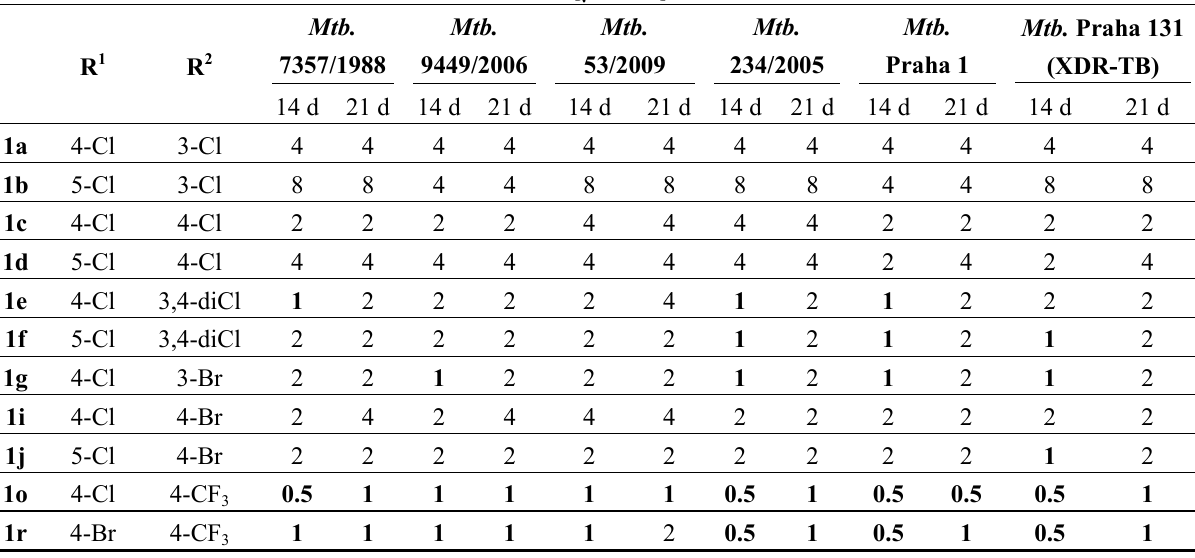
Table 2. MICs of salicylanilide 4-(trifluoromethyl)benzoates 1 towards MDR- and XDR-TB. MIC [  mol/L] R 1 R 2